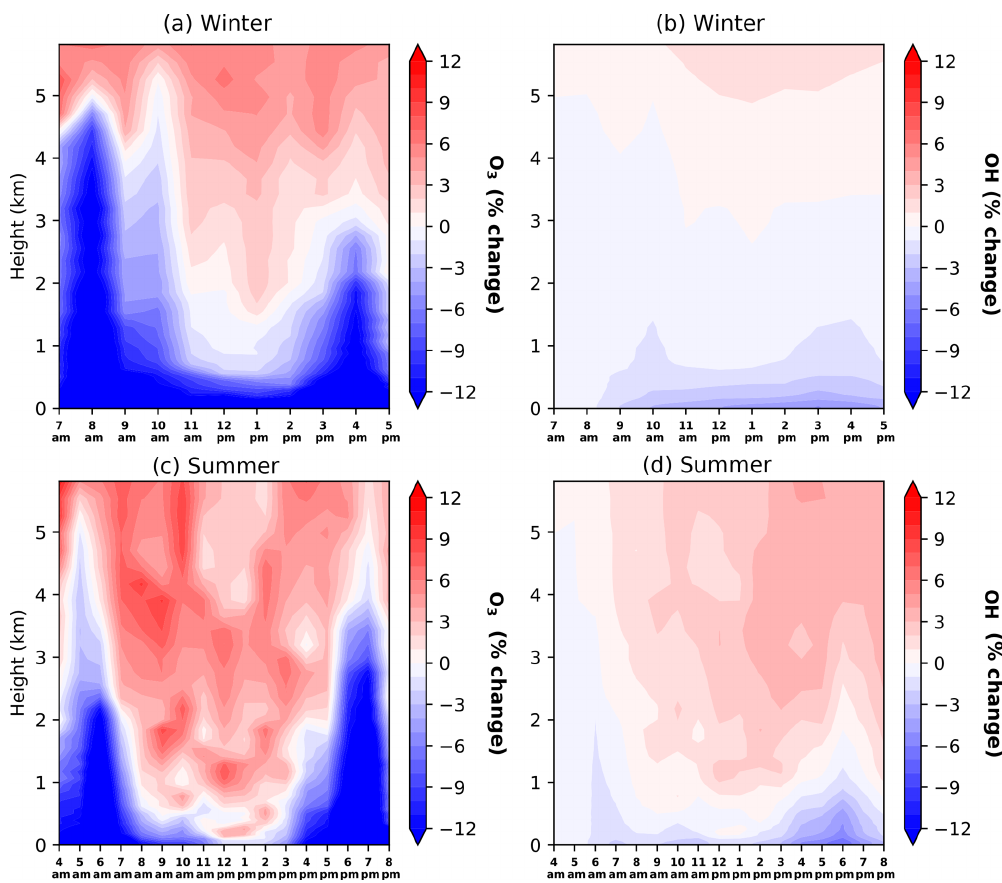
Figure 6. Diurnal profiles of aerosol impacts on O 3 (a, c) and OH (b, d) concentrations for winter (a, b) and summer (c, d) campaign periods. These changes are calculated using a simple chemical box model, and plots show the mean relative difference with respect to clear-sky conditions, with blue representing a reduction due to aerosols and red representing an